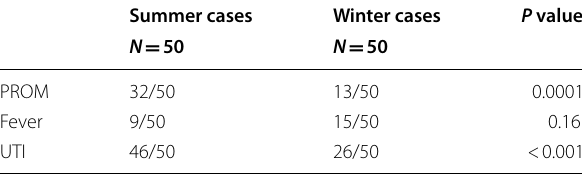
Table 3 Comparison of maternal conditions of the cases